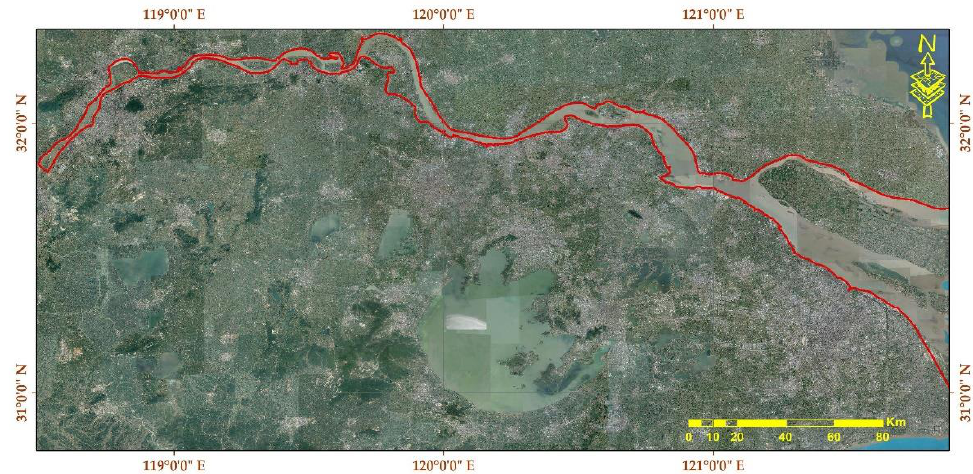
Figure 1. The geographical scope of the